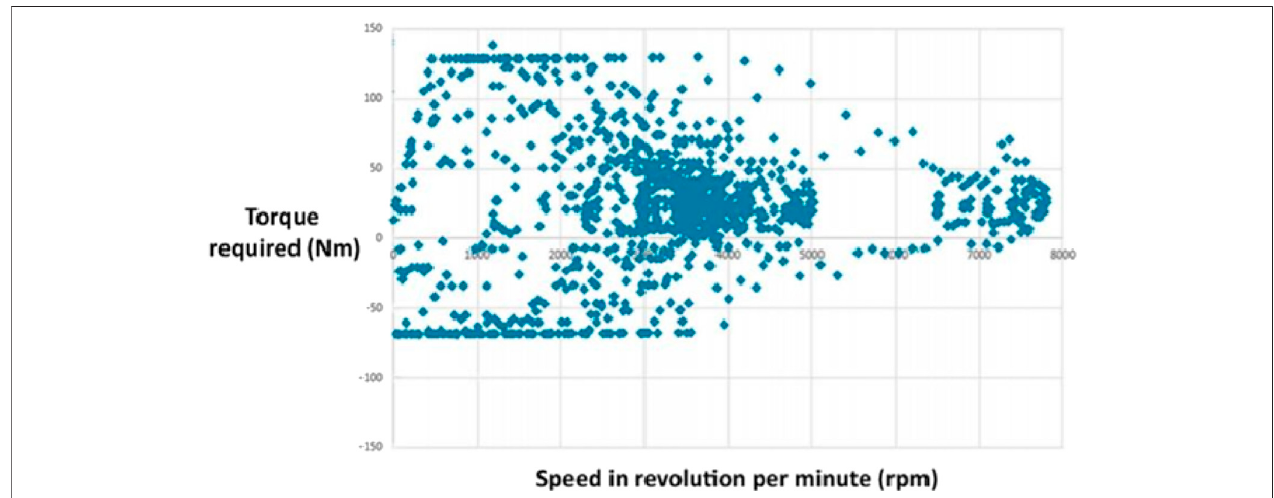
FIGURE 3 | Federal Urban Driving Schedule torque-speed requirements. Data from (Chan, 2014).